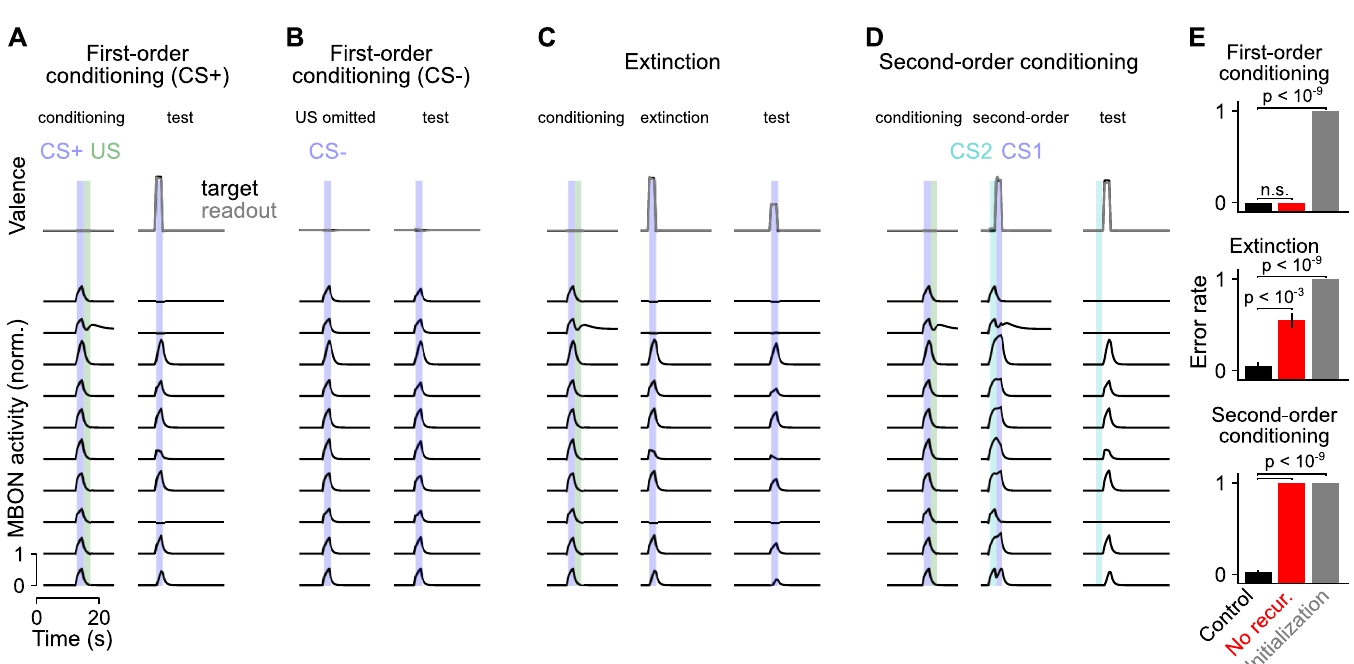
Fig 3. Behavior of network during reward conditioning paradigms. (A) Behavior of output neurons (MBONs) during first-order conditioning. During training, a CS+ (blue) is presented, followed by a US (green). Top: The network is optimized so that a readout of the output neuron activity during the second CS+ presentation encodes valence (gray curve). Black curve represents the target valence and overlaps with the readout. Bottom: Example responses of output neurons. (B) Same as A , but for CS- presentation without US. (C) Same as A , but for extinction, in which a second presentation of the CS+ without the US partially extinguishes the association. (D) Same as A , but for second-order conditioning, in which a second stimulus (CS2) is paired with a conditioned stimulus (CS1). (E) Error rate averaged across networks in different paradigms. An error is defined as a difference between reported and target valence with magnitude greater than 0.2 during the test period. Networks optimized with recurrent output circuitry (control, black) are compared to networks without recurrence (no recur., red), and networks prior to optimization (initialization, gray). Error rates for each network realization are evaluated over 50 test trials and used to generate p -values with a Mann-Whitney U -test over 20 network realizations.